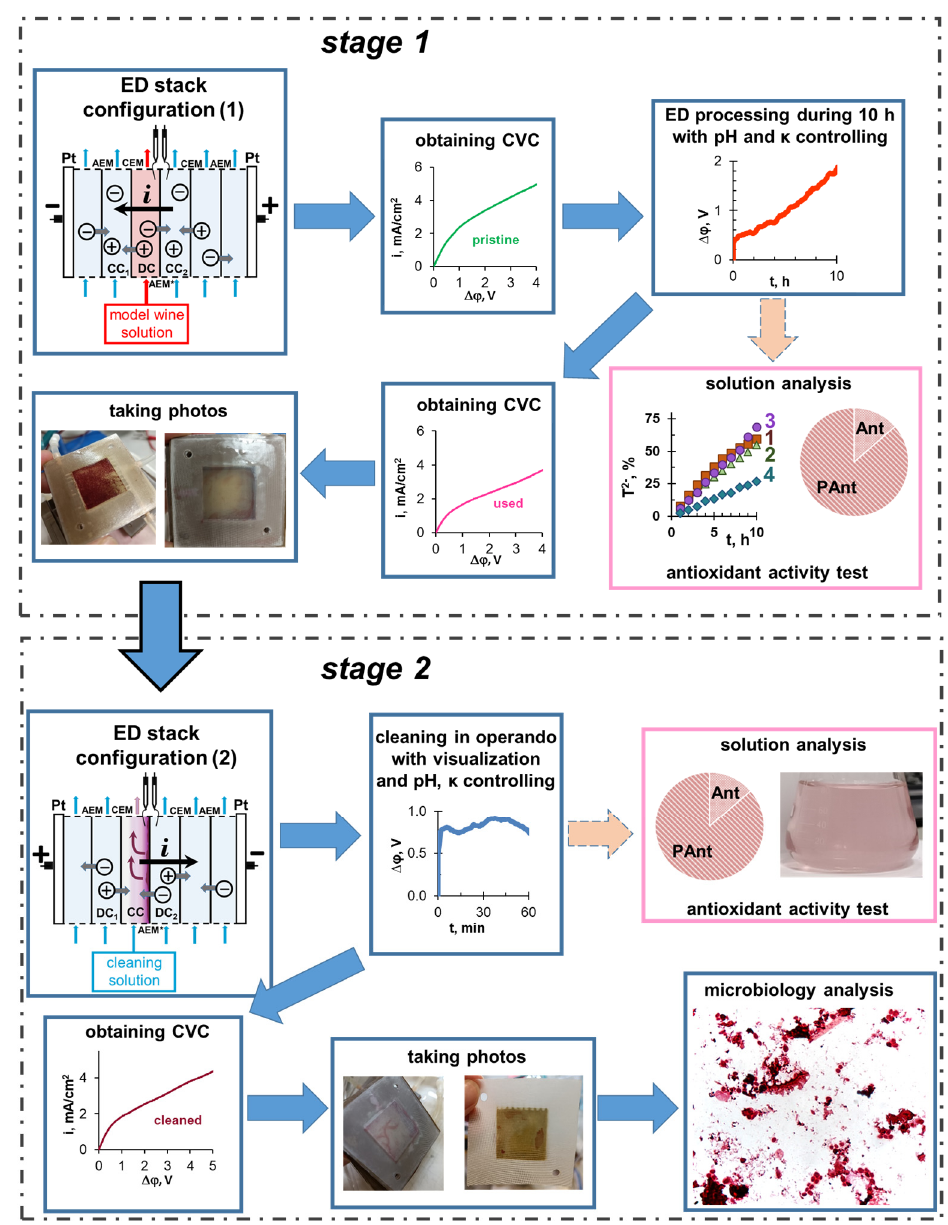
Figure 1. Scheme of the protocol for the implementation of experiments.